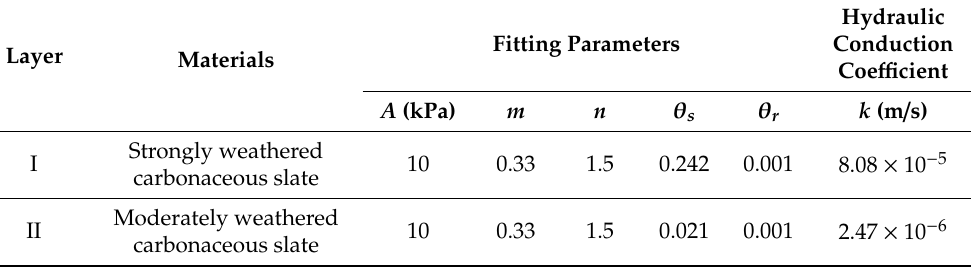
Figure 6. Variations in pore water pressure at the different positions under different a and n: ( a ) Top of the slope; ( b ) Middle of the slope; ( c ) Bottom of the slope; ( d ) Top of the slope; ( e ) Middle of the slope; ( f ) Bottom of the slope. Table 2. Parameters of the water retention curve.